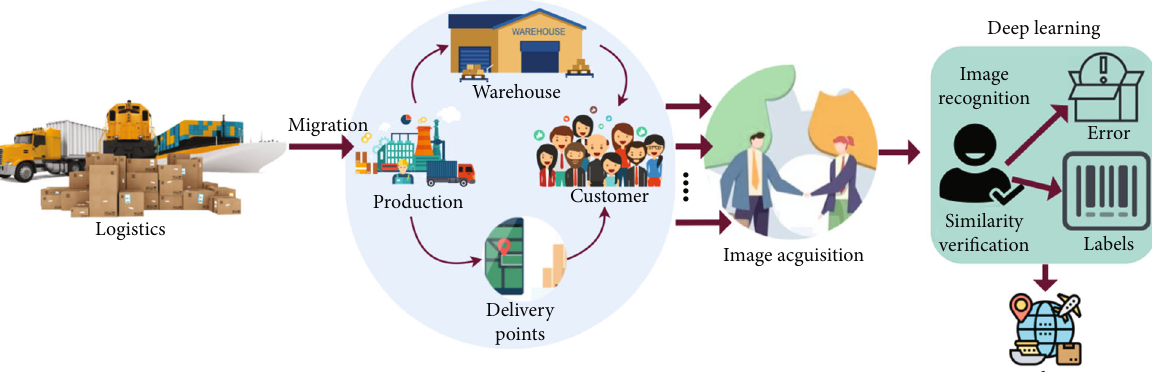
Figure 1: Proposed